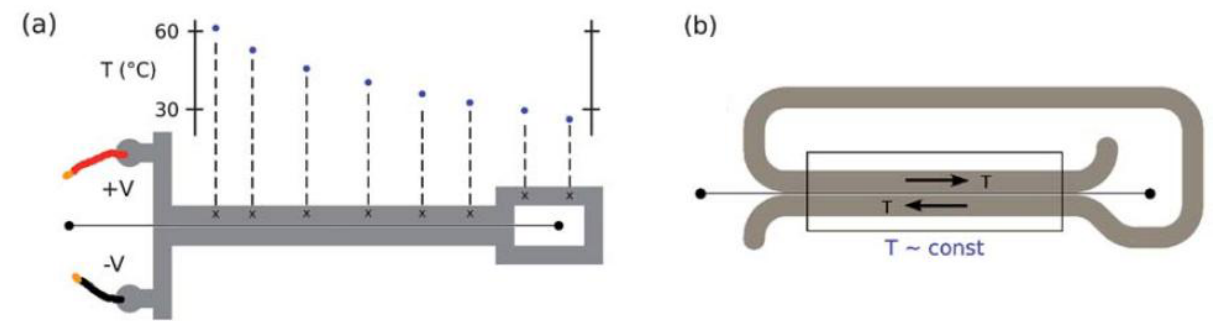
Figure 23. ( a ) Plot of the temperature along the channel surrounded by channels filled with an epoxy. ( b ) A schematic view of a device that is able to create a constant temperature. Reprinted with permission from [43]. Copyright 2010, Royal Society of